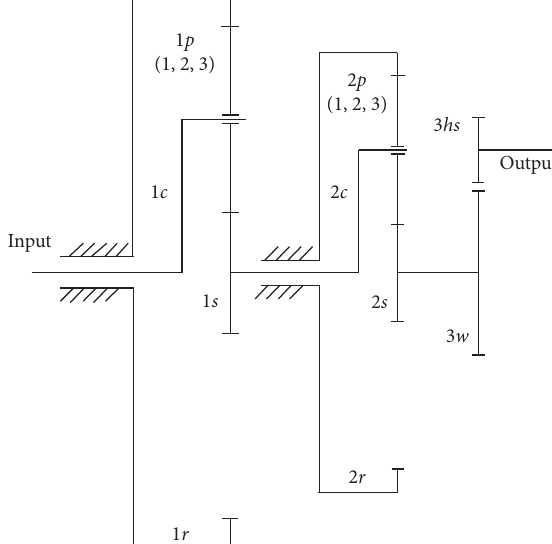
Figure 3: Drive principle of the faulted gearbox